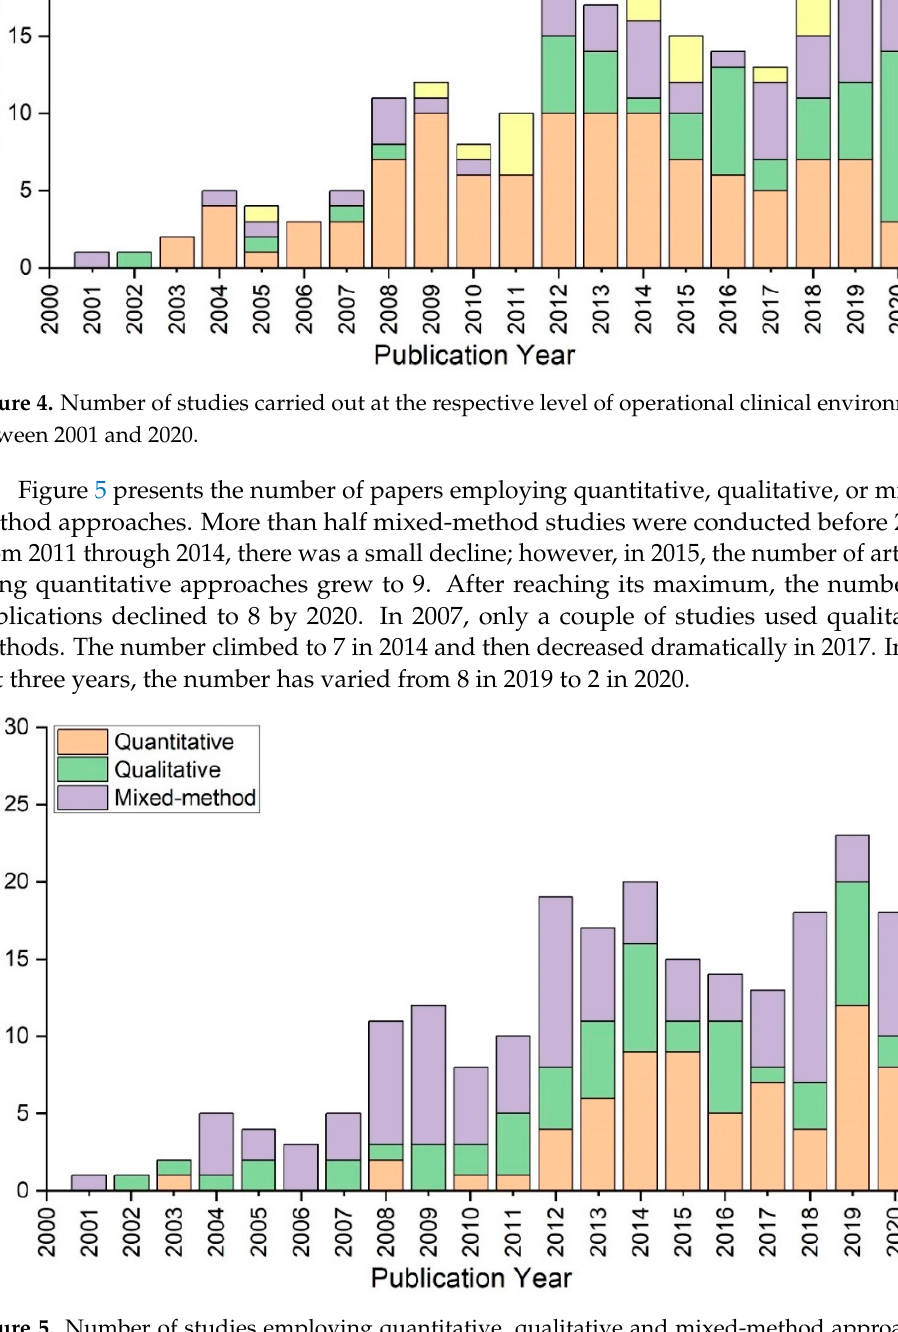
Figure 5. Number of studies employing quantitative, qualitative and mixed-method approaches between 2001 and 2020.